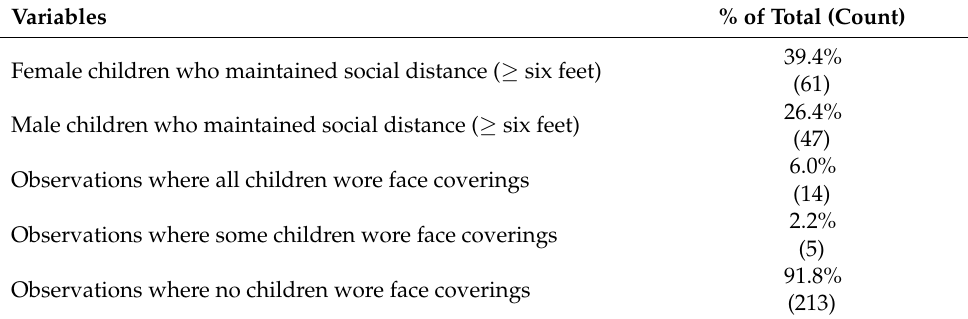
Table 3. Adherence to COVID-19 protective health behaviors of children at joint-use parks outside of school